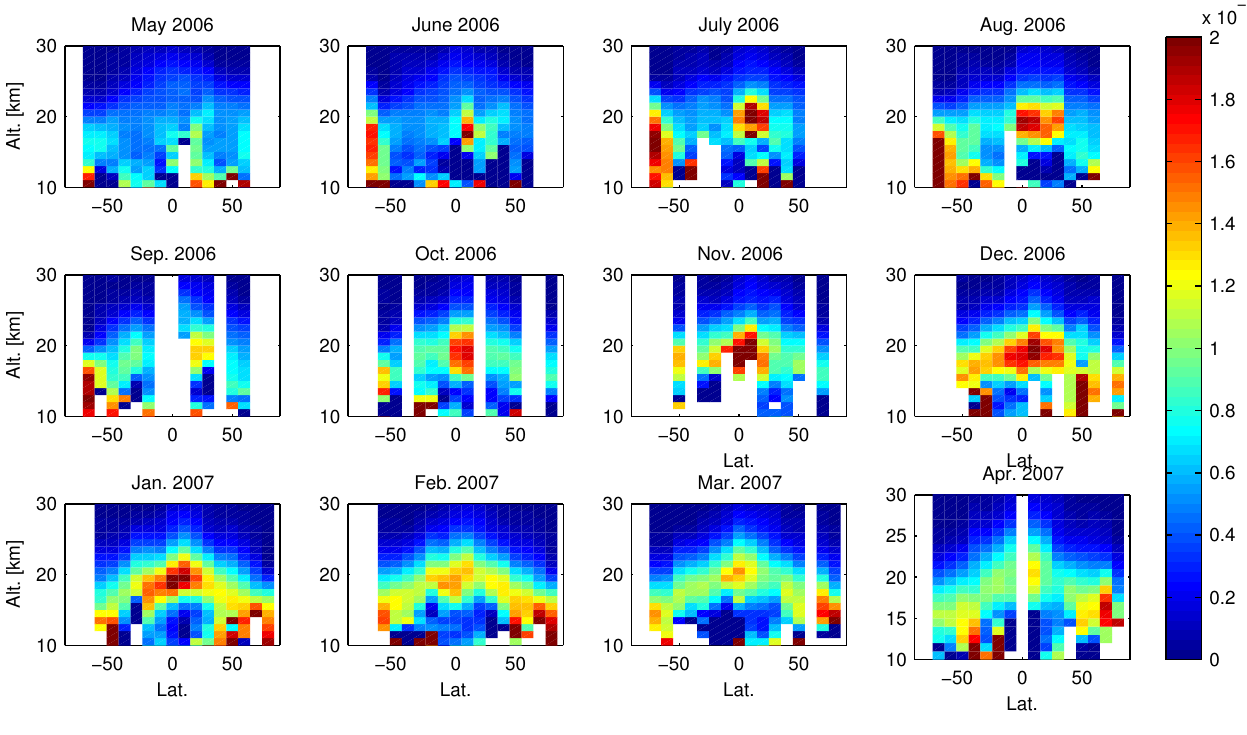
Fig. 8. Evolution of the volcanic stratospheric aerosols resulting from the Soufri`ere Hills eruption on 20 May 2006. Shown are monthly zonal median aerosol extinction coefficients at 500nm. Starting from the eruption site (Montserrat, 16.72 ◦ N, 62.18 ◦ W), the plume disperses poleward and encircles the entire earth within a year.